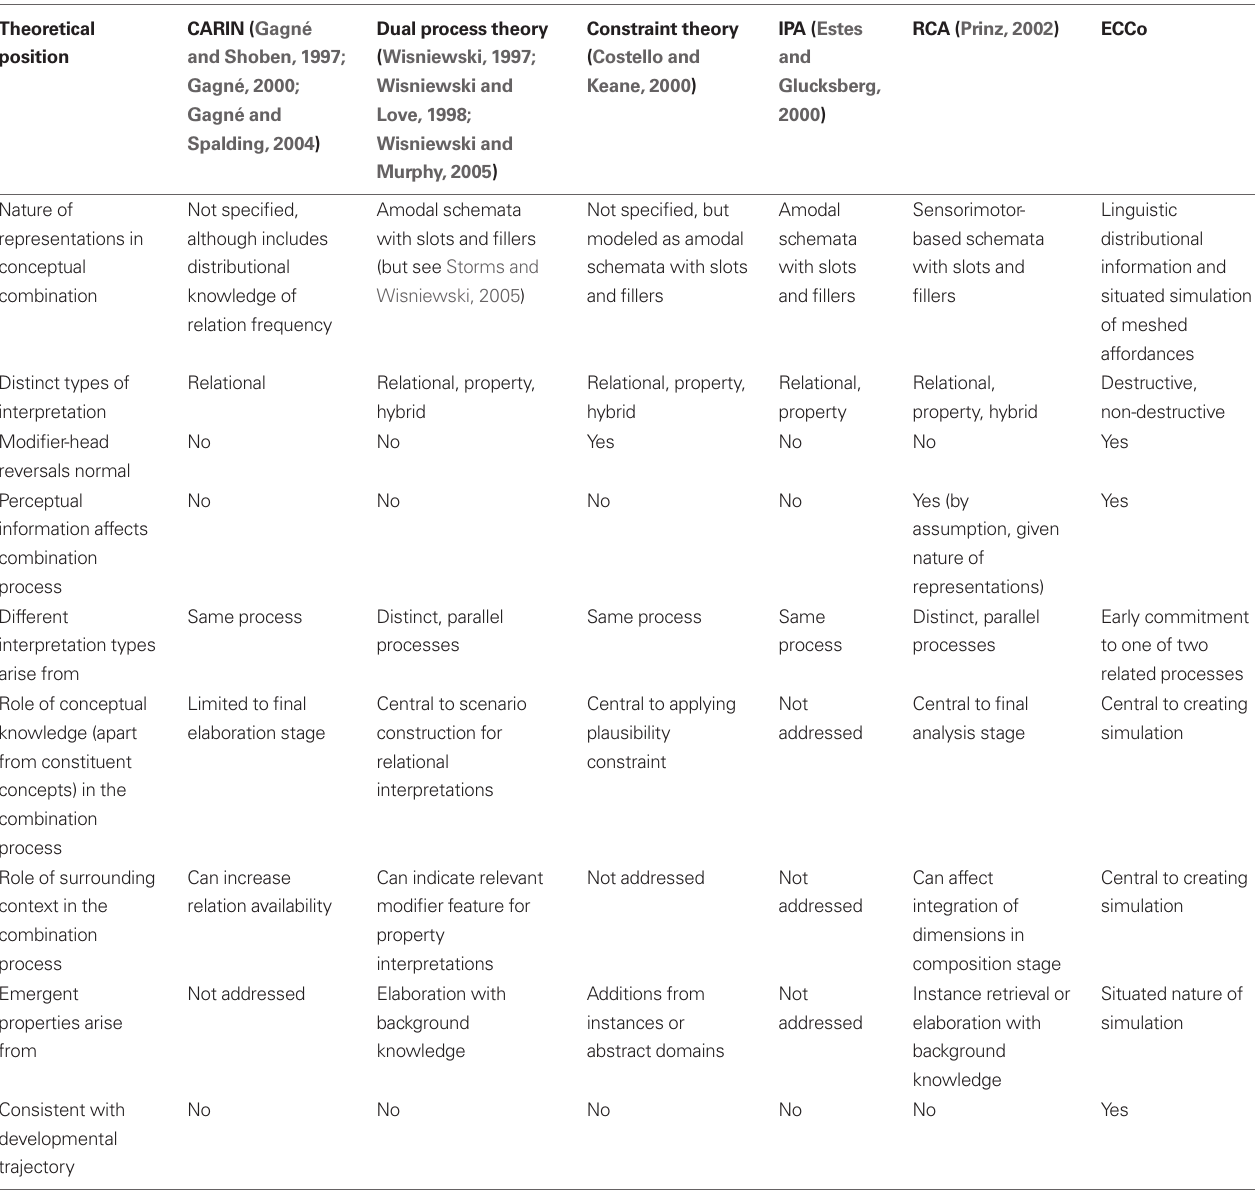
Table 1 | Comparison of ECCo with existing theories of conceptual